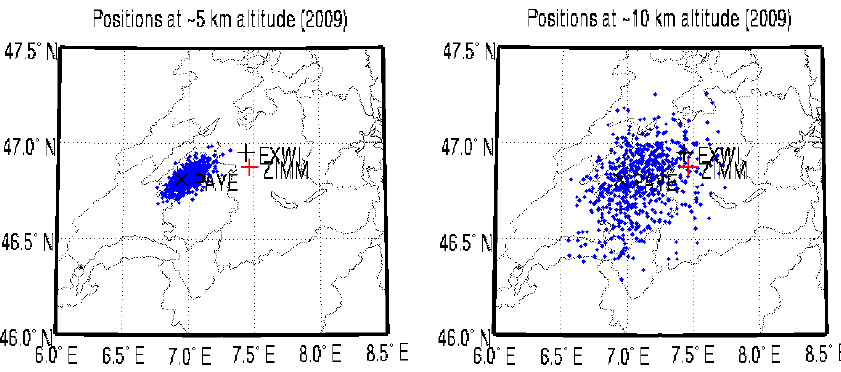
Fig. 16. Distribution of sonde positions when crossing 5km a.s.l. (left) resp. 10km a.s.l. (right). EXWI: ExWi Building of the Univ. of Bern, ZIMM: Zimmerwald Observatory, PAYE: MeteoSwiss